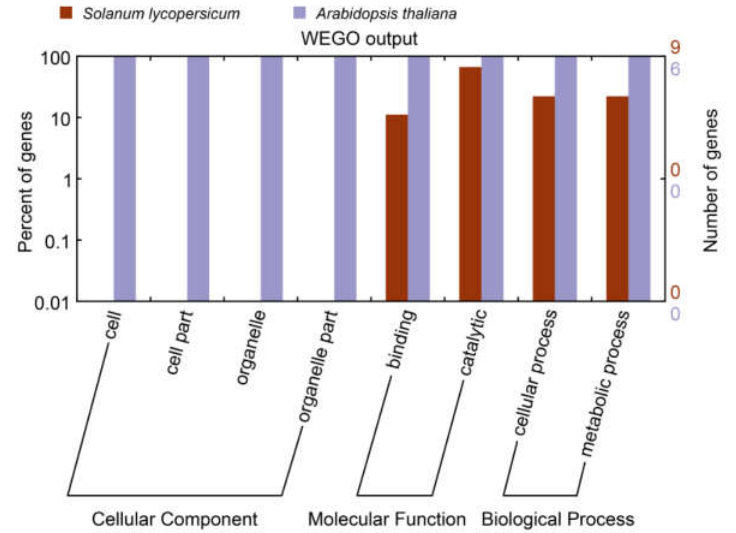
Figure 6. Assignment of Gene Ontology categories to UGlcAE genes in tomato. The lengths of the rectangular columns indicate the number of genes that participated in the corresponding classification. The purple rectangular columns mean gene functions of UGlcAE in Arabidopsis , the red rectangular columns represent gene functions of UGlcAE in tomato. All of the gene functions were classified into three categories, which were further divided into eight minor terms.